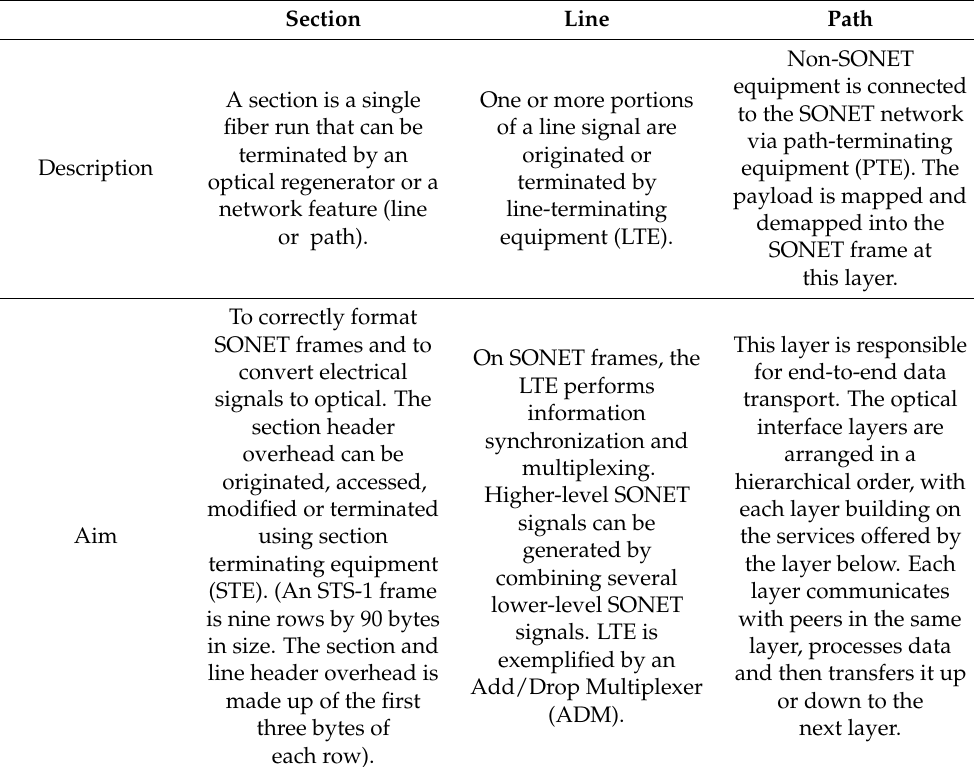
Table 9. Details of SONET hierarchy